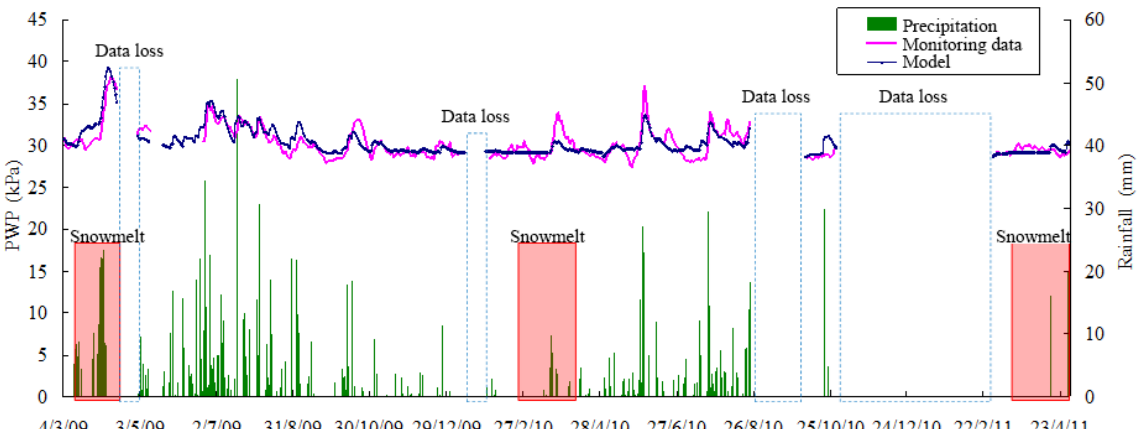
Figure 13. Long-term consistency simulation of PWP using the modified tank model throughout the entire monitoring period (4 March 2009– 23 April